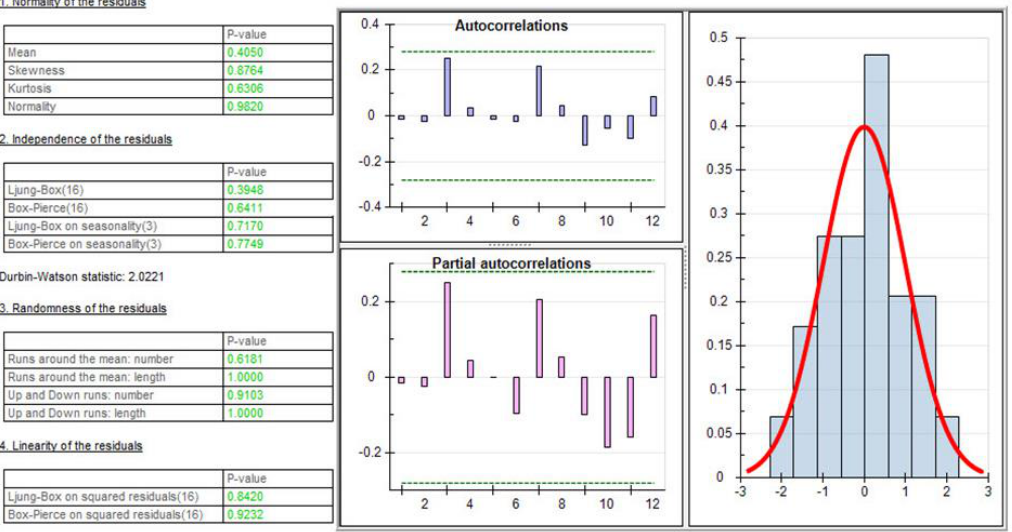
Figure 4. Test of normality of value added of industry